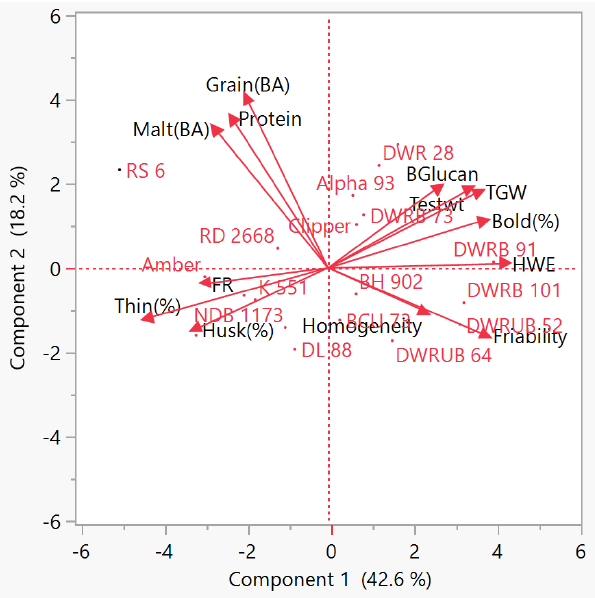
Figure 3. Principal component analysis (PCA) of barley genotypes (in red font) based on the 13 traits (in black font) (variables).